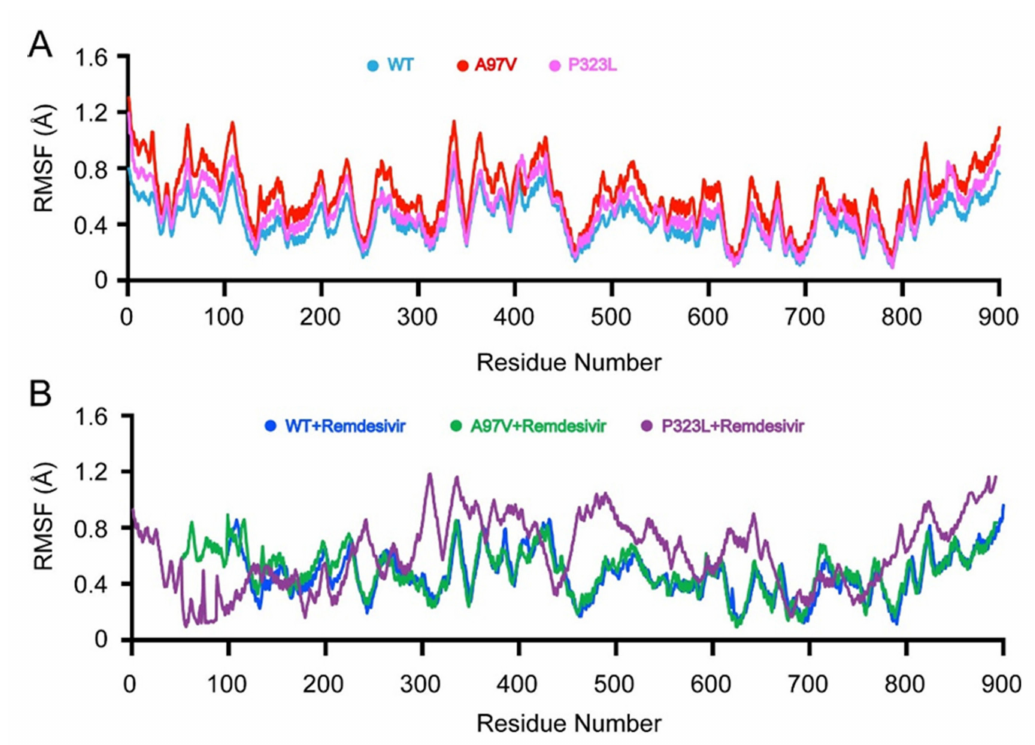
Figure 4. RMSF plot of 200-ns simulations of RdRp in apo and complex with RDV. Apo WT, A97V and P323L RdRp ( A ) and